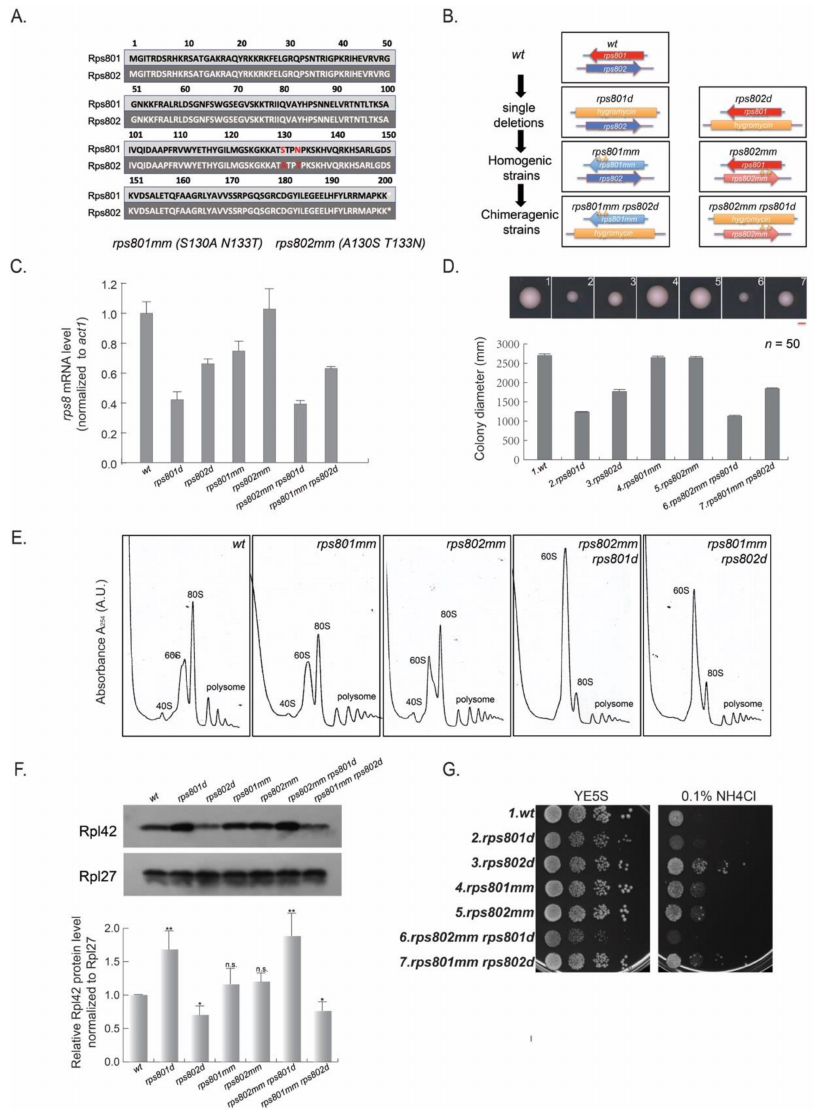
Figure 3. Differential transcription level of Rps8/eS8 paralogs results in the divergence phenotype of the Rps8/eS8 paralogs. ( A ) Comparison of the Rps8/eS8 paralog protein sequence. Rps801 and Rps802 differ in protein sequence by only two residues: 130aa and 133aa—the 130aa: S in Rps801p and A in Rps802p and the 133aa: N in Rps801p and T in Rps802p. ( B ) Diagram illustrating the genetic construction of homogenic strains and chimeric strains. Details seen in Table S2. ( C ) Quantification of the relative rps8 mRNA level normalized to act1 by qRT − PCR. ( D ) Quantification of the colony size reflecting growth rates among rps8 mutants. Cells derived from wild − type, rps8 paralog deletions, and chimeric strains, as well as homogenic strains, were planted at the density of one cell/cm 2 by microscopic manipulation on YE + 5S plates, incubated at 29 ◦ C for four days. Each colony is photo − documented on the 4th day, and colony diameters are measured with Photoshop software. At least 50 colonies are calculated for each strain. The representative colony for each strain is shown. relative abundance of 40S, 60S, and 80S ribosomes and polysomes. ( F ) Comparison Rpl42/eL42 protein levels among the wild − type and rps8 genetic mutants by Western blotting. p − values were obtained by the two − tailed Fisher’s exact test. * p < 0.05; ** p < 0.01. ( G ) Comparison cell growth of the wild − type, rps8 paralog deletions, and chimeric strains, as well as homogenic strains in YE supplied with excess NH 4